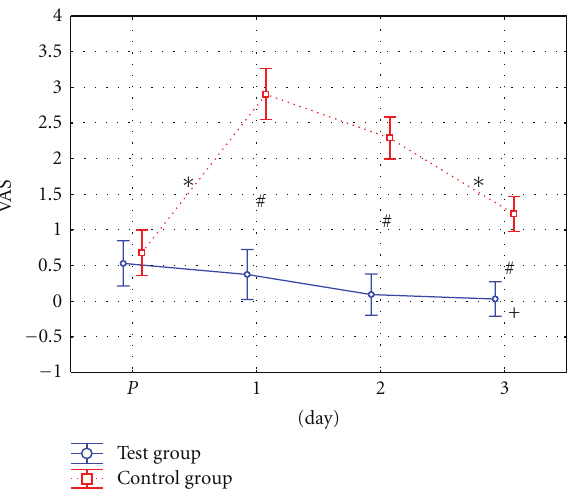
Figure 2: Graphic comparison of pain perception on VAS scale (in pts.) in patients from test and control groups. ∗ —statistically significant di ff erence ( P ≤ 0 . 05) between consecutive tests. #— statistically significant di ff erence ( P ≤ 0 . 05) between groups in particular tests. +—statistically significant di ff erence ( P ≤ 0 . 05) in relation to initial test.